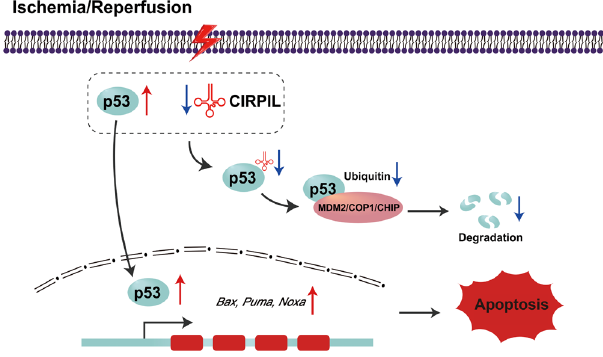
Fig. 9 Schematic diagram depicting the proposed signaling mechanisms underlying the effects of lncCIRPIL in the setting of I/R. Upon ischemia/ reperfusion stress, the level of lncCIRPIL is decreased and p53 is increased in cardiomyocytes. The reduction of lncCIRPIL sequesters less p53 for ubiquitination mediated degradation. Thereby, more p53 translocate to nucleus to trigger the transcription of target genes to initiate